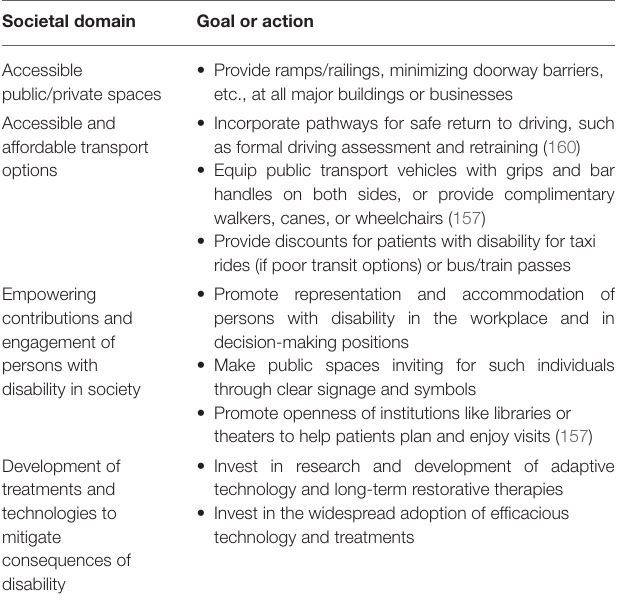
TABLE 4 | Action items for societies to address to help maintain EVT benefits in stroke survivors at 5 years and beyond. Societal